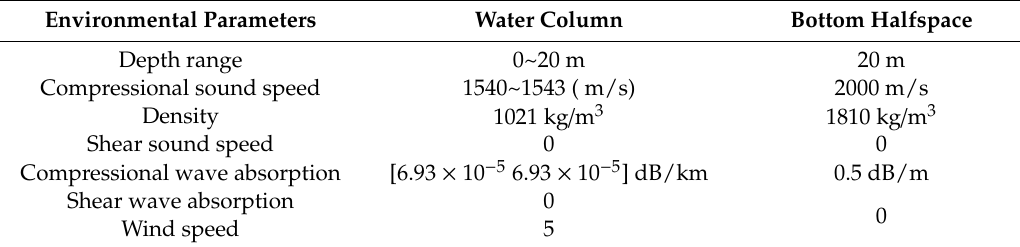
Table 2. The water environment parameter of the Bellhop